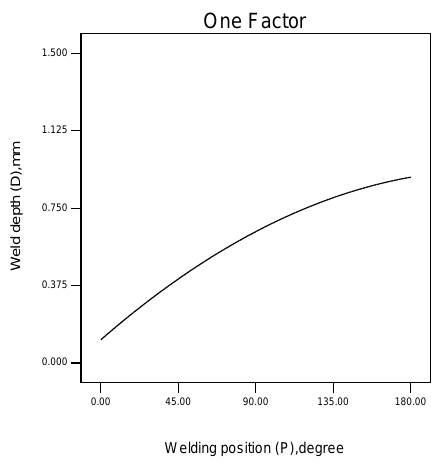
Figure 11. Influence of welding position on weld depth.